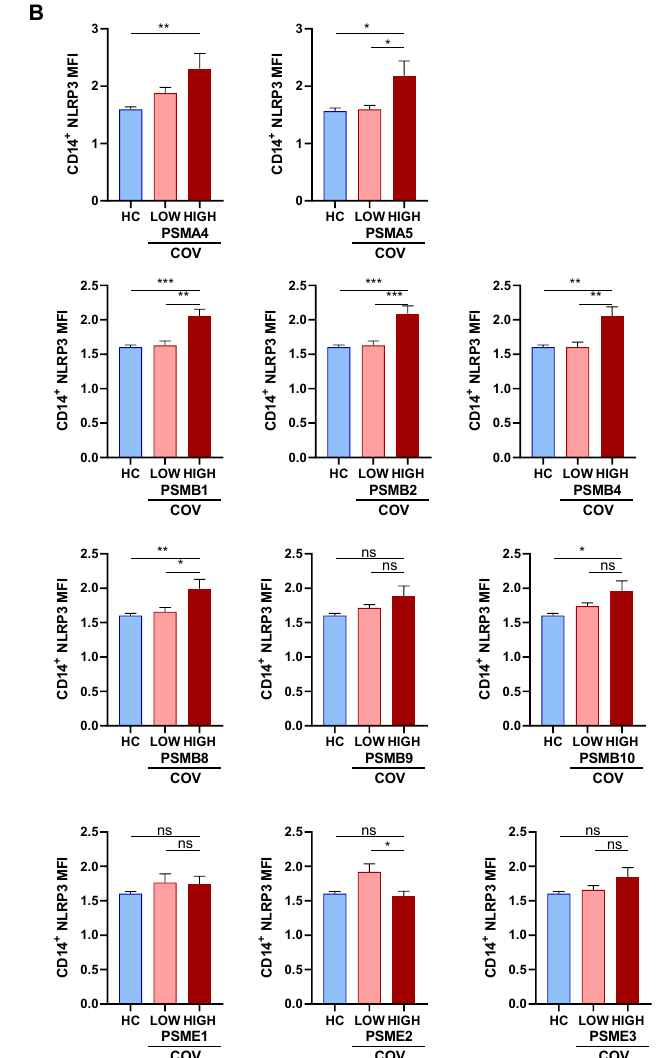
Figure 4. Proteasome subunits relationship with inflammation components. ( A ) Heatmap represents Spearman’s correlation coefficient ( ρ ) between proteasome subunits mRNA expression and genes related to inflammation mRNA expression. White gaps represent non-significant correlations, while the rest of correlations are significant ( p < 0.05). ( B ) NLRP3 expression in monocytes analysed by flow cytometry in monocytes from healthy controls (HC), and COVID-19 patients (COV) presenting LOW or HIGH expression of proteasome subunits. Mean differences were analysed using one-way ANOVA analysis with Tukey’s multiple comparisons test. Error bars: standard error of the mean. *: p < 0.05, **: p < 0.01, ***: p < 0.001. In this line, we evaluated NLRP3 protein expression in CD14 + monocytes (gated